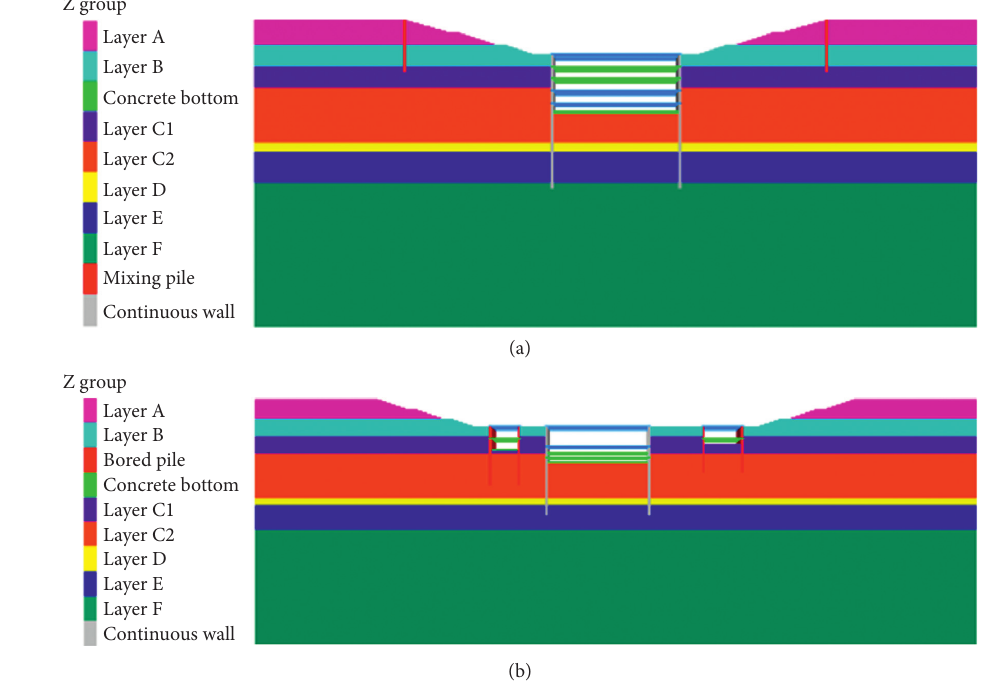
Figure 7: Simplified model of the pits in district B2-J1. (a) Model of the NW area. (b) Model of the SE